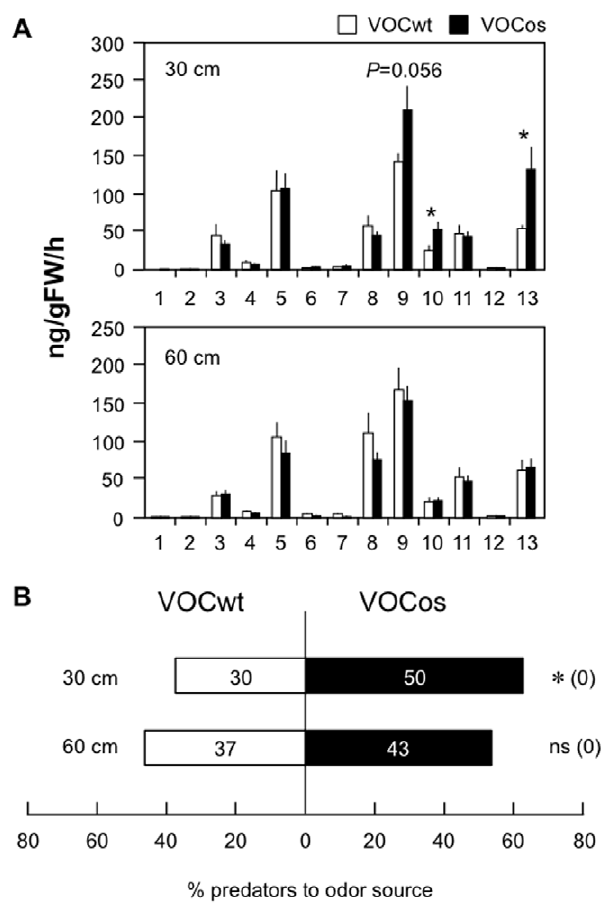
Figure 5. Indirect defenses of VOCos/VOCwt-exposed lima bean plants in greenhouse conditions. Uninfested plants were placed 30 or 60 cm apart from NtOS2 (VOCos) or WT (VOCwt) in a greenhouse for 7 days. The receiver plants were treated with T. urticae for 1 day and subjected to VOC collections ( A ) and olfactory assays of predatory mites ( B ). Asterisks indicate significant differences from control volatiles (Student’s t-test, P , 0.05). For more information, see Figures 3 and 4.